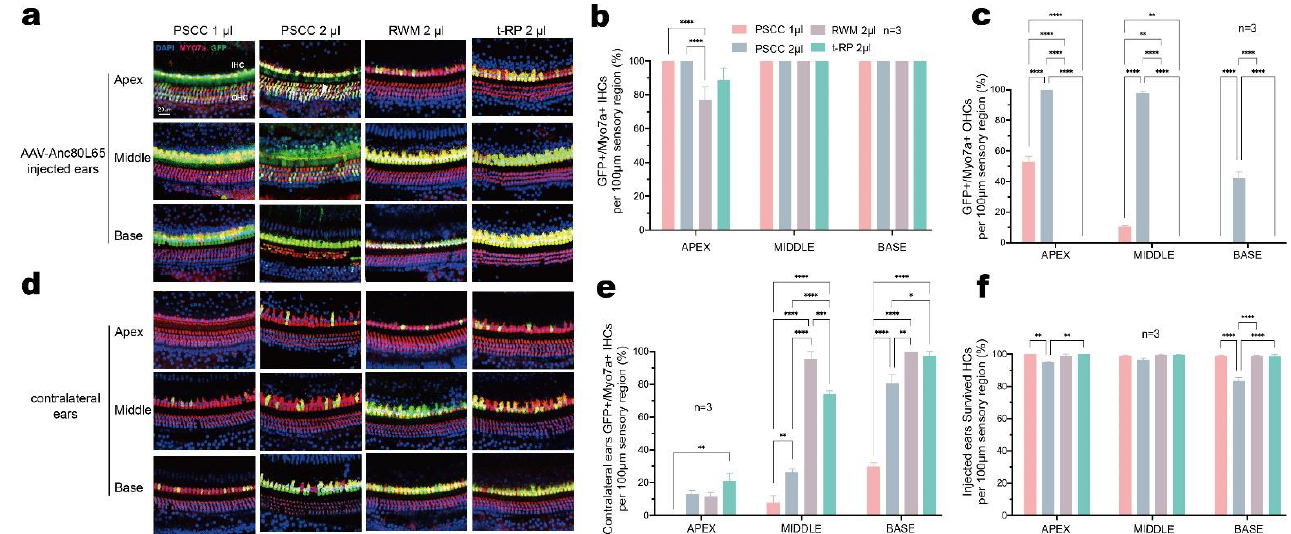
Figure 2. The AAV delivery approaches make a difference in HC transduction and HC survival in the adult cochlea. The cochleae were harvested 2 weeks after AAV-Anc80L65 was delivered into the adult cochlea (4 – 6 weeks old). HCs were labeled with Myo7a (red), the nuclei were stained with DAPI (blue), and native eGFP was observed (green). ( a , d ) Representative high-magnification images of the apex, middle, and base in the AAV-Anc80L65 (1.0 × 10 13 VG/mL)-injected ears ( a ) and contralateral ears ( d ). ( b , c ) Quantitative comparison of IHC transduction efficiency ( b ) and OHC transduction efficiency ( c ) in injected ears in the four different groups as assessed in 100 μm segments across different regions of the cochlea (apex, middle, and base). ( e ) Quantitative comparison of IHC transduction efficiency in the contralateral ears in the four different groups, as assessed in 100 μm segments across different regions of the cochlea (apex, middle, and base). ( f ) Quantification of HCs survival at 2 weeks after AAV-Anc80L65 injection via the different approaches in adult mice, as assessed in 100 μm segments across different regions of the cochlea (apex, middle, and base). Two-way ANOVA with Bonferroni correction was performed for multiple comparisons of transduction rates and survival rates. * p < 0.05, ** p < 0.01, *** p < 0.001, **** p < 0.0001. To avoid the difference in inner ear transduction by the virus as much as possible, we delivered Anc80L65 into adult cochleae with the same AAV titer and volume (1.0 × 10 13 VG/mL) via the RWM and t-RP approaches. RWM injection in mice was reported to be well-tolerated at larger volumes of 2 µ L [36]. We found a variable transduction efficiency across tonotopic positions for IHCs (RWM group: apex 77.02 ± 7.53%, middle 100%, base 100%; t-RP group: apex 88.64 ± 7.31%, middle 100%, base 100%) (Figure